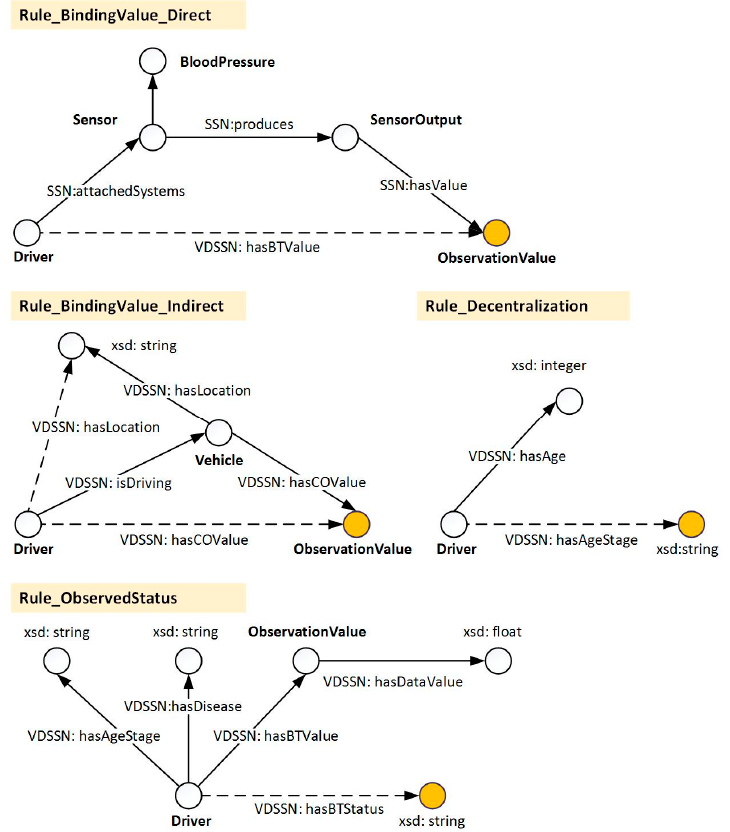
Figure 4. Demonstration of the reasoning processes.